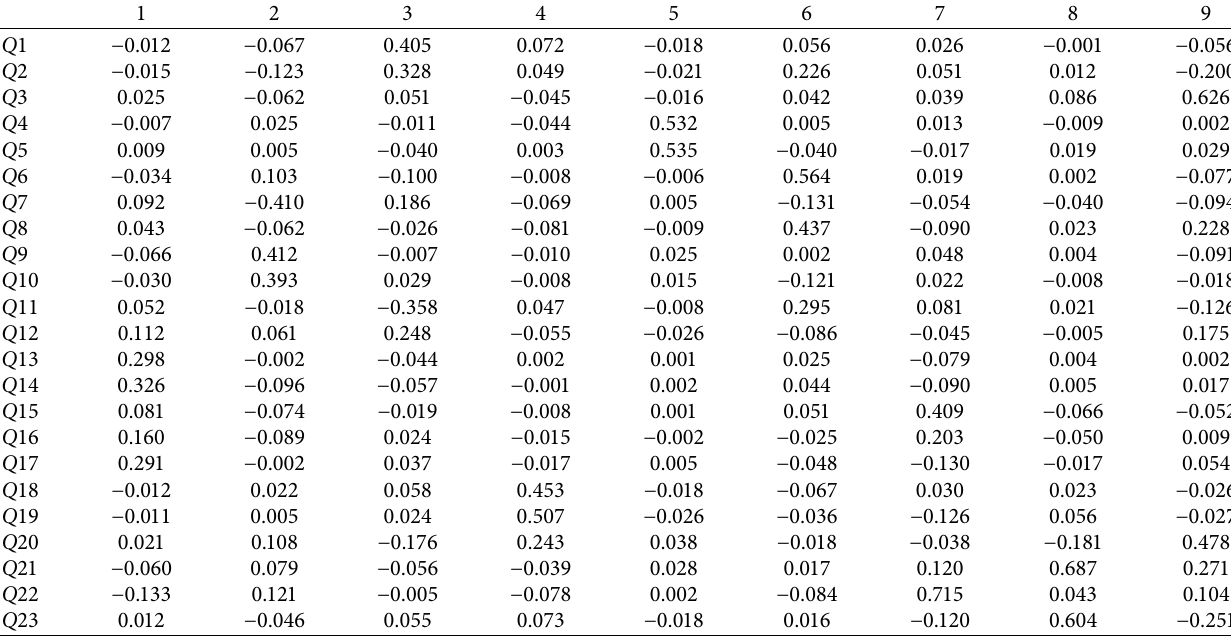
Table 8: Component score coefficient